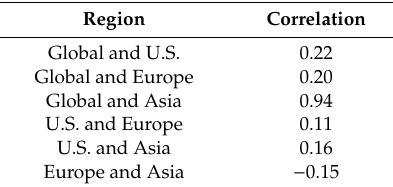
Table 5. Correlations of quarterly investments in fintech between global investment, U.S., Europe and Asia from 2013 to